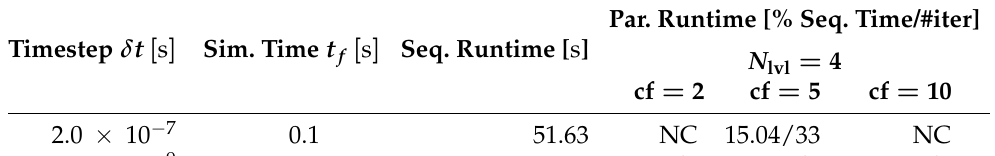
Table 4. Runtimes for sufficiently small time-step to allow convergence in the microgrid test case. Time-steps of this size would usually not be used in applications, but the results prove that better speed-ups are possible if the alignment of coarse step size and switching period is